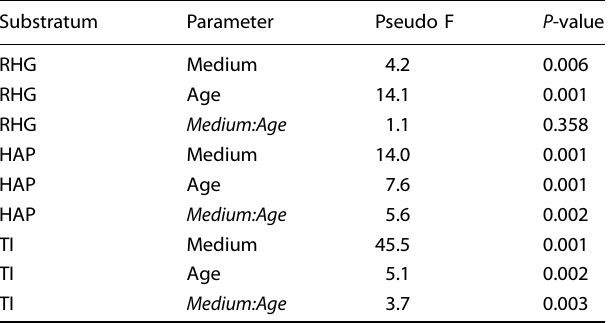
Table 1. One-way PERMANOVA